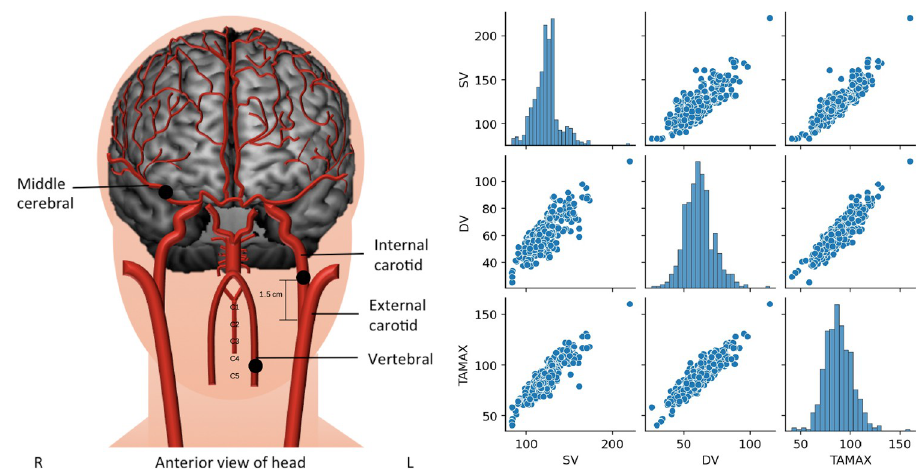
Fig 1. Anatomy of cerebral vasculature with approximate locations of measurement and example of doppler ultrasonography dependencies in the right middle cerebral artery. On the left, for the middle cerebral arteries measurements are taken in the M1 segment. For the internal carotid arteries measurements are taken 1.5 cm distal to the bifurcation (i.e., where the common carotid artery divides into the internal and external carotid arteries) for the internal carotid artery. For the vertebral arteries measurements are taken in the C4-C5 inter-transverse segment (between the C4 and C5 vertebrae). On the right, we illustrate doppler dependencies among peak systolic velocities (SV), end-diastolic velocities (DV), and time-averaged maximum (TAMAX) velocities. Histograms are on the diagonal and scatter plots for corresponding pairs of features are given off the diagonal.